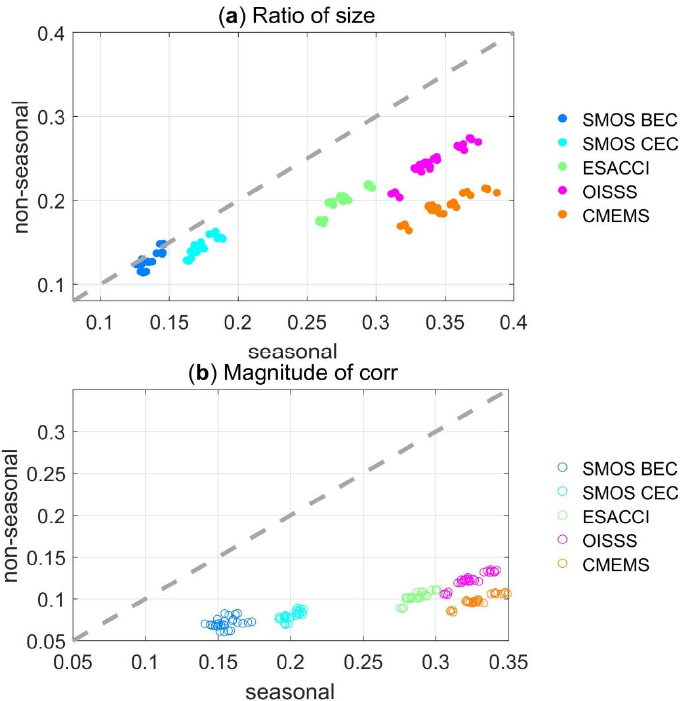
Figure 8. ( a ) Ratio of the size of the positive correlation area to the size of the global ocean derived from the seasonal time scale versus the nonseasonal time scale. ( b ) denotes the same as ( a ) but for the magnitude of the correlation coefficients. The dots denote correlation coefficients calculated between SSS tendency based on 5 products (different colors) and 28 sets of FWF (same color). The hollow cycles in ( b ) indicate the correlation between FWF and SSS tendency on seasonal and nonseasonal time scales is not significant ( p -values > 0.05).